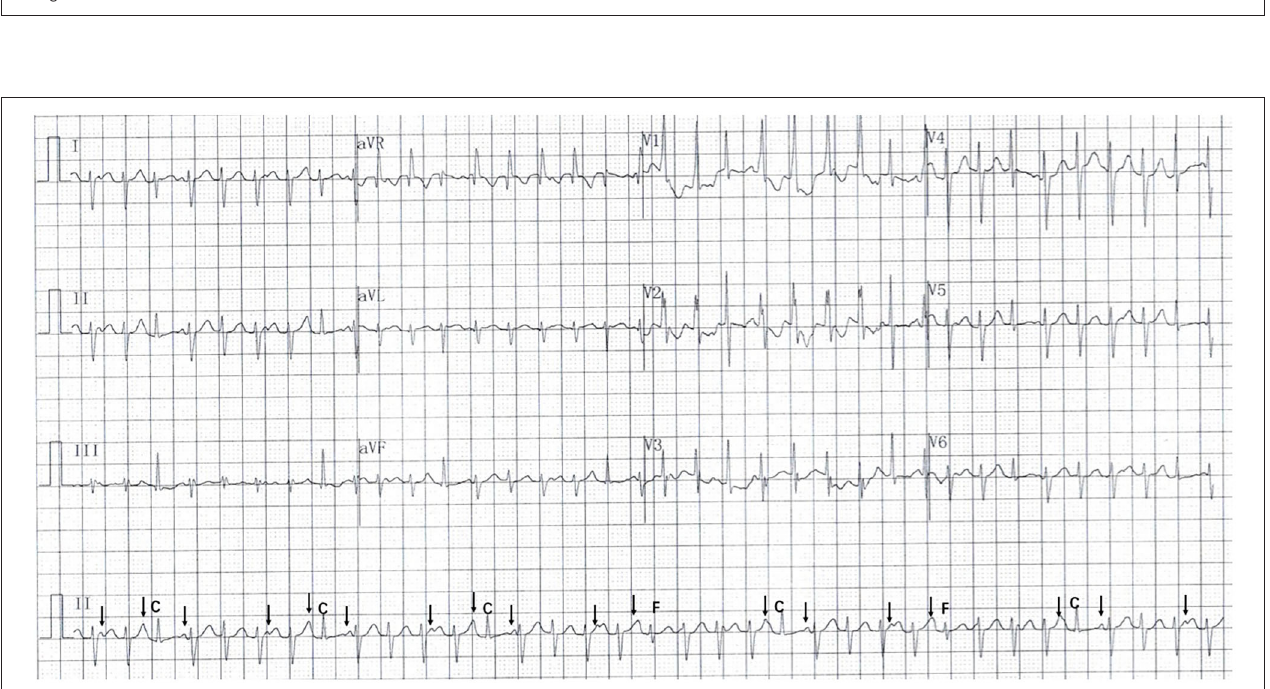
FIGURE 2 | The electrocardiogram following amiodarone infusion revealed atrioventricular (AV) dissociation (arrow), capture beats (C), and fusion beats (F).